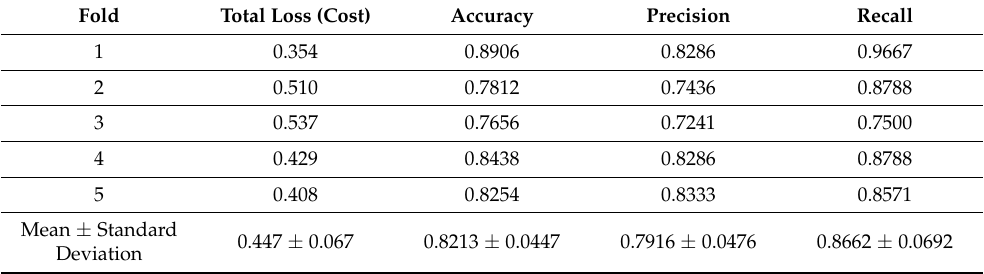
Table 4. Evaluation metrics for each fold. The last row demonstrates the mean and standard deviation of the final epochs of all folds.